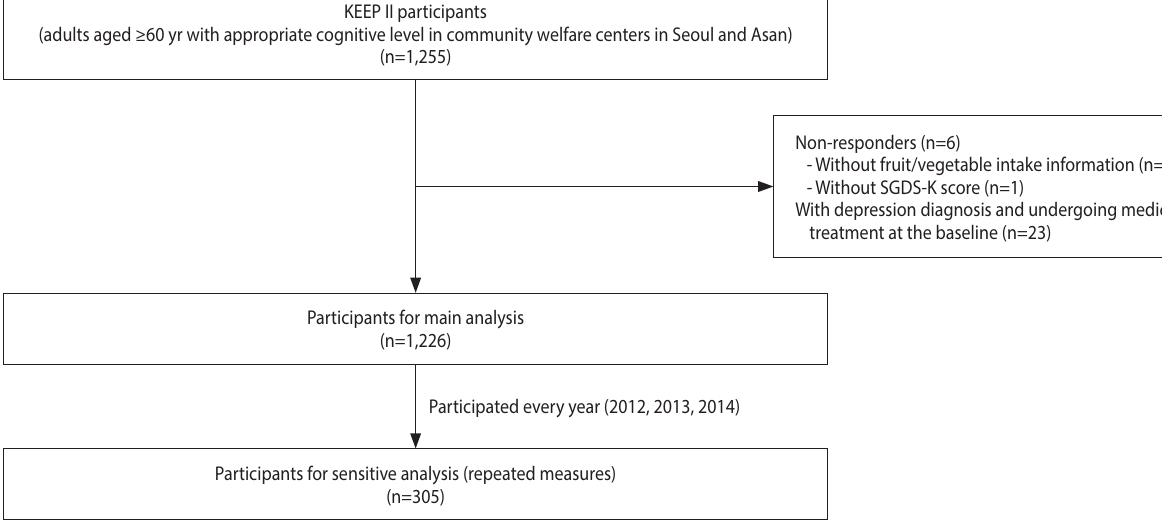
Figure 1. Selection of participants. KEEP, Korean Elderly Environmental Panel; SGDS-K, Korean version of the Short form Geriatric Depression